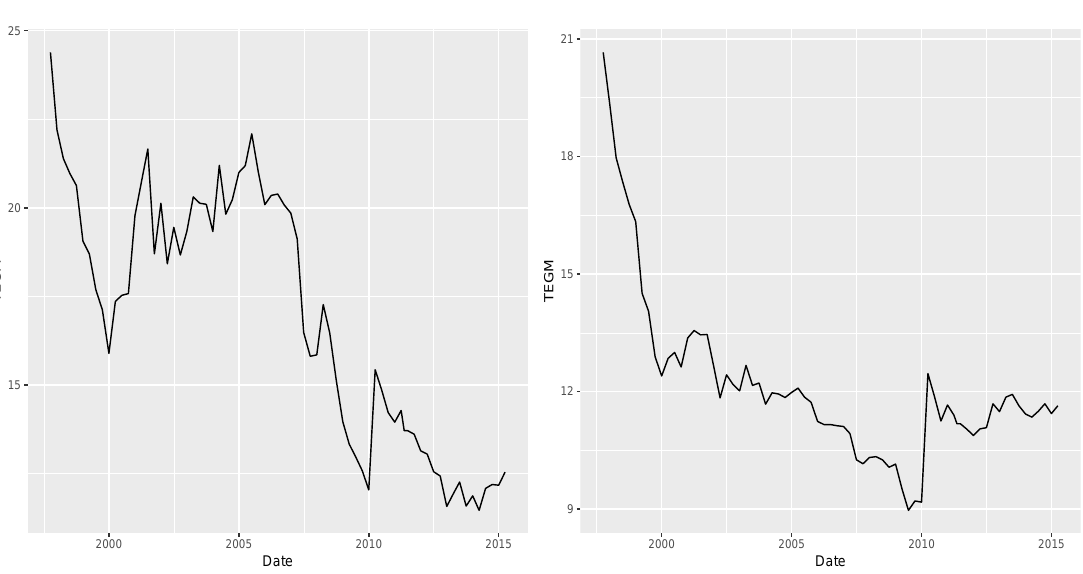
Figure 1. TEGM for one-fifth of salary transfer up to e 5000 (on the left ) and above e 5000 (on the right